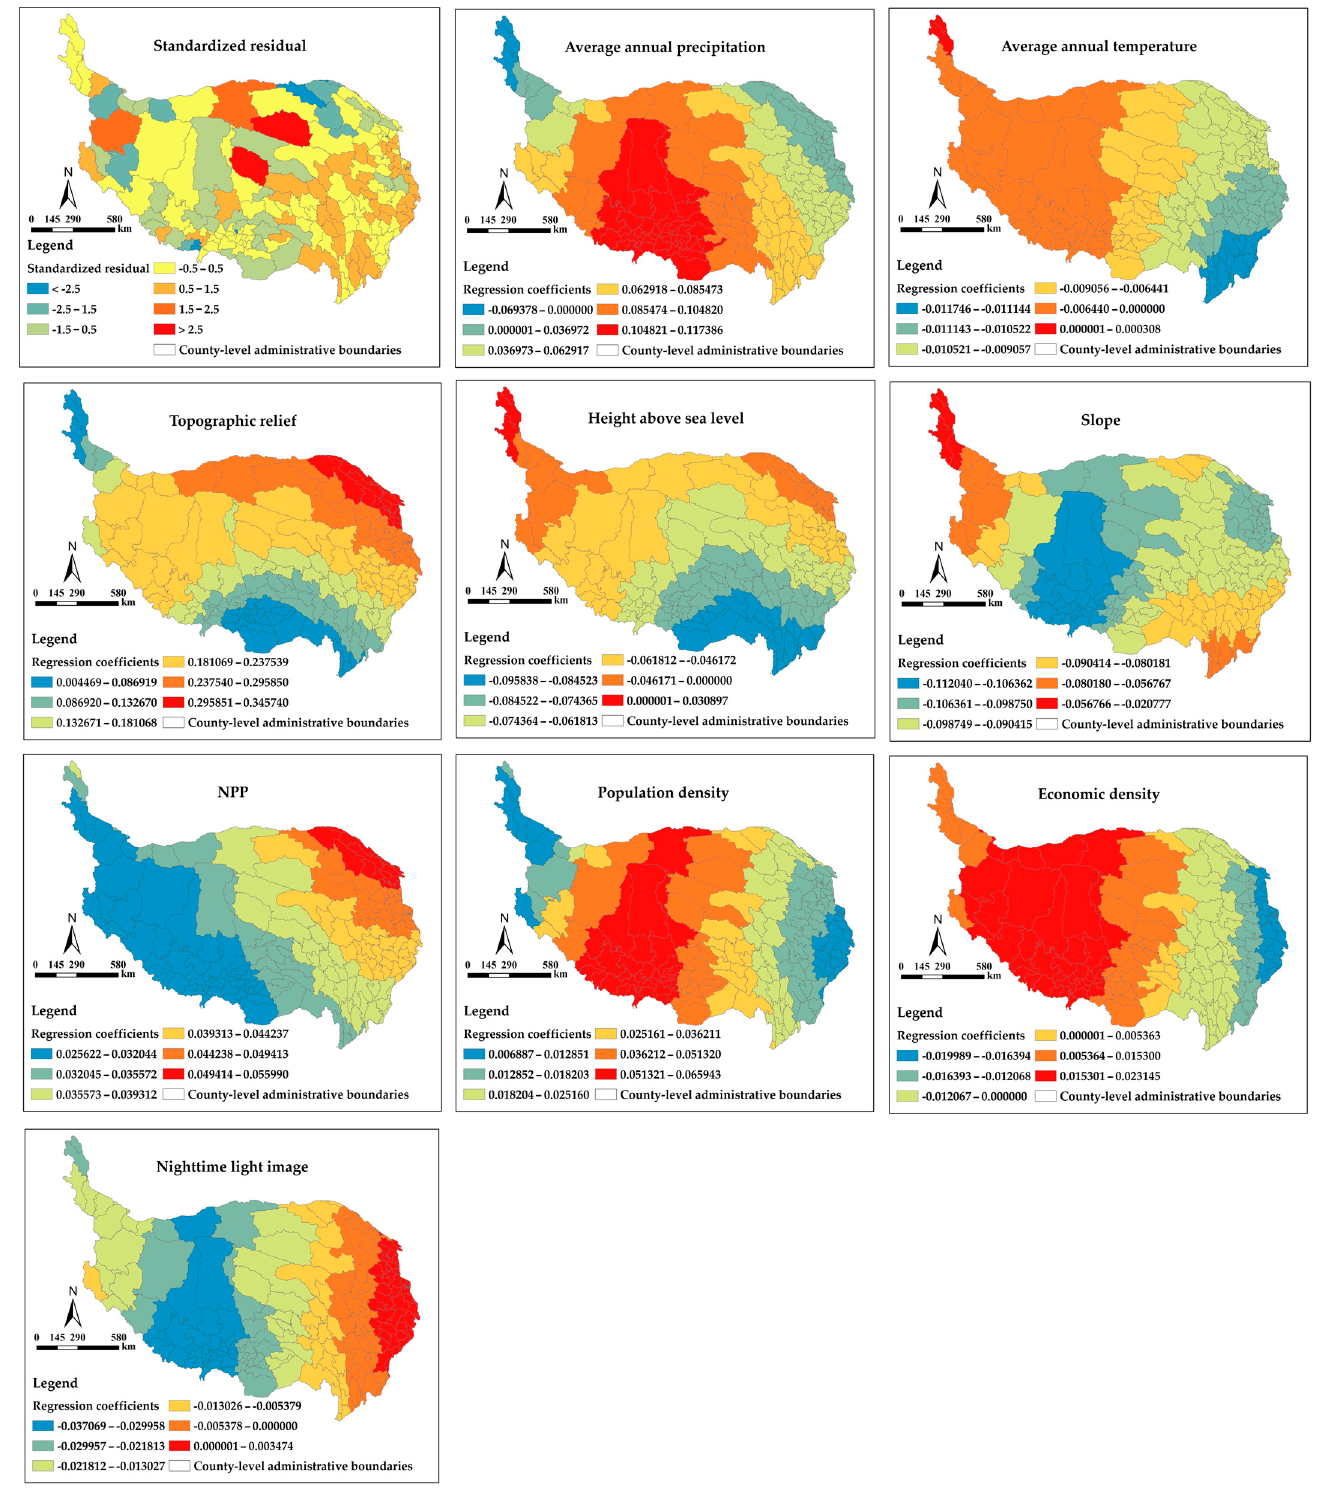
Figure 7. Spatial distribution of standardized residual and regression coefficients of driving factors.